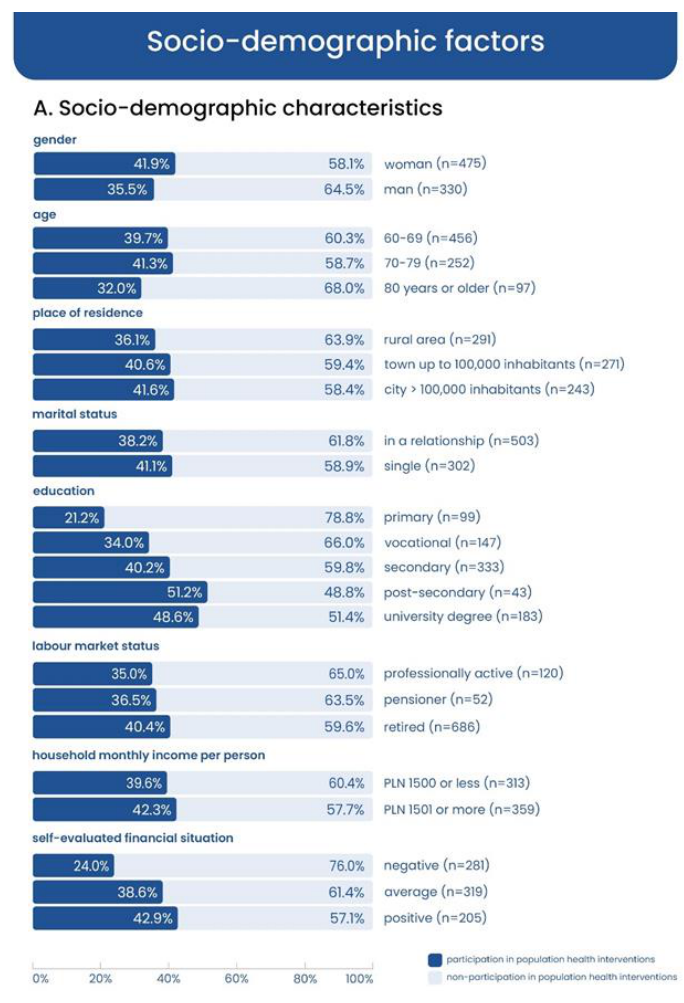
Figure 2. Participation in health programmes in subgroups (participating and non-participating) based on socio-demographic factors (in percentage)..